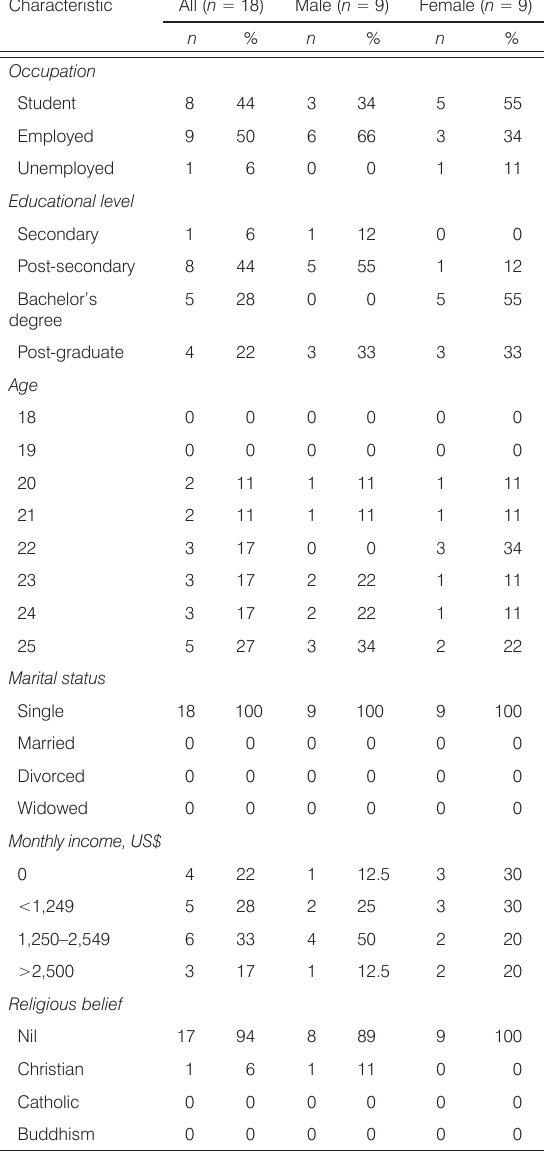
Table 2. Characteristics of focus groups